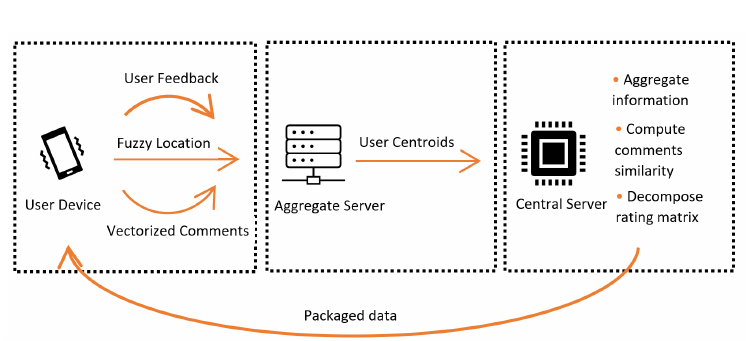
Figure 2. The overall model structure and the tasks of each component as well as the data flow. The next component’s primary task is the user clustering on the aggregator